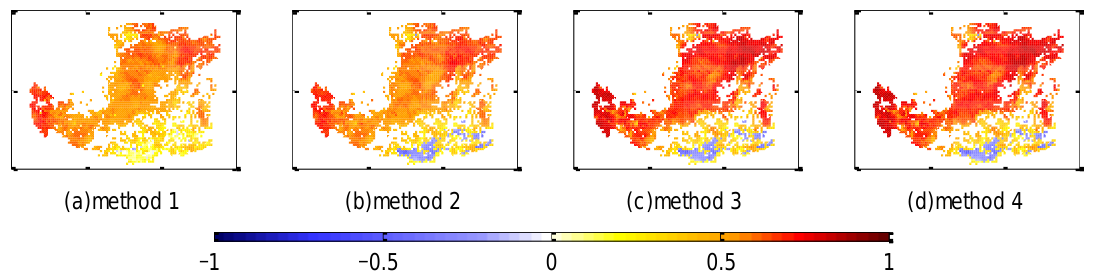
Figure 4. The correlation coefficient between normalized difference vegetation index (NDVI) and precipitation was formulated by different time lag